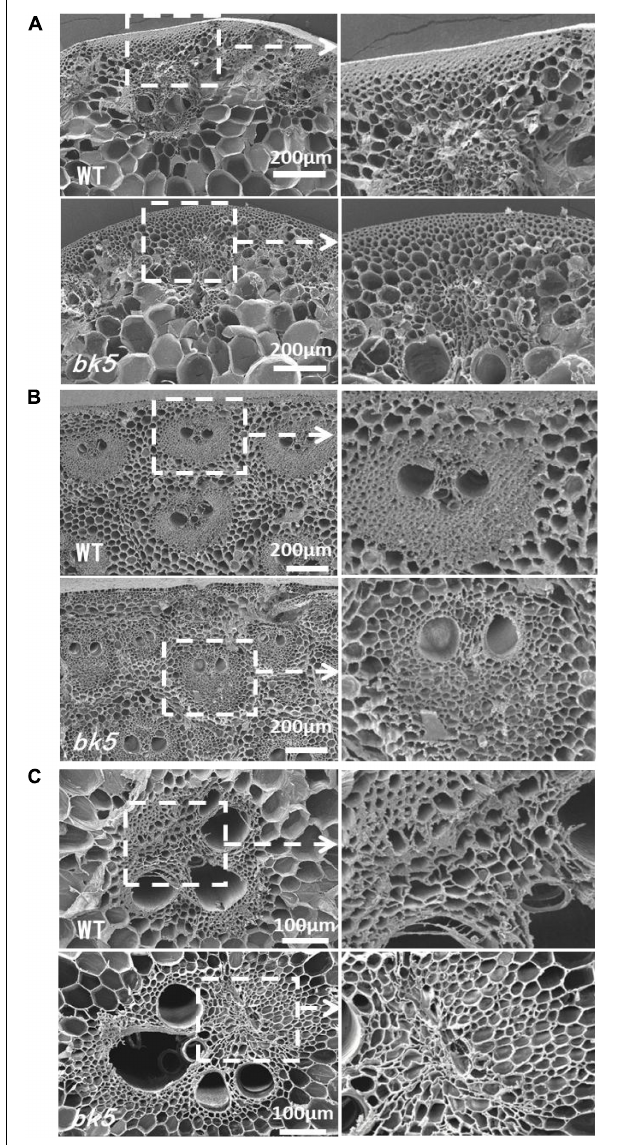
FIGURE 2 | Scanning electron micrographs of bk5 and WT stems and veins taken from cross sections. (A) Leaf veins and local enlargement. (B) Rind regions of the stalk and local enlargement of the vascular bundle. (C) Central regions of the stalk and local enlargement of vascular bundle.